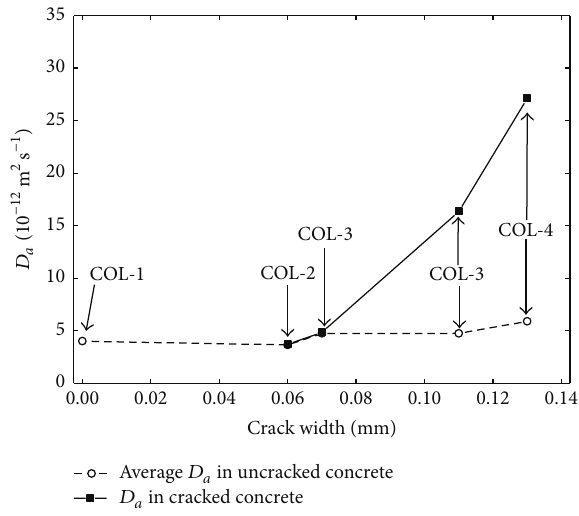
Figure 10: Chloride diffusion coefficient of uncracked and cracked concrete of column specimens.